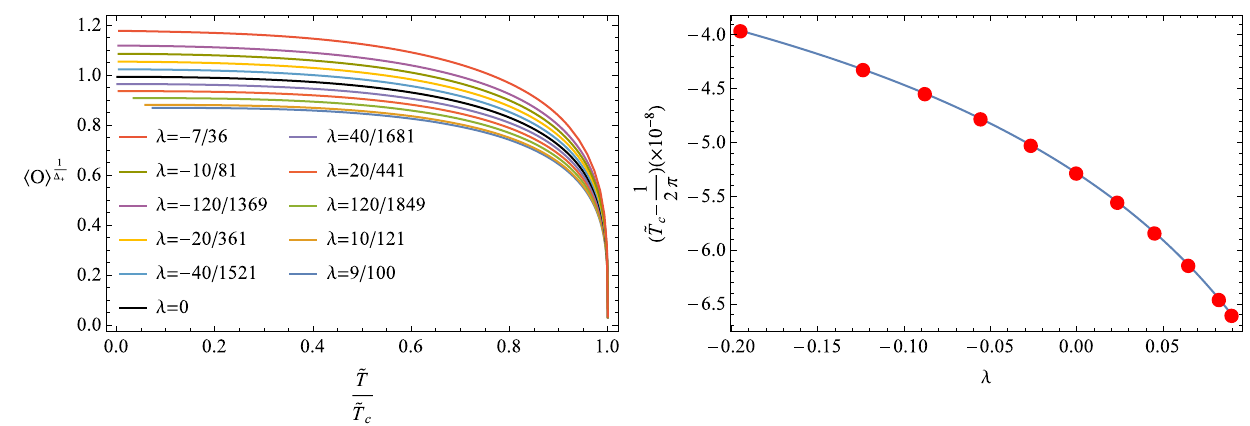
Fig. 6 Left: The condensate as a function of the temperature (scaled by the corresponding critical temperature) for the various values of λ when (cid:16) + = 2. The lowest curve is for λ = 9 and the top one corresponds to the λ = − 7 . Right: The critical temperature as a function of 100 36